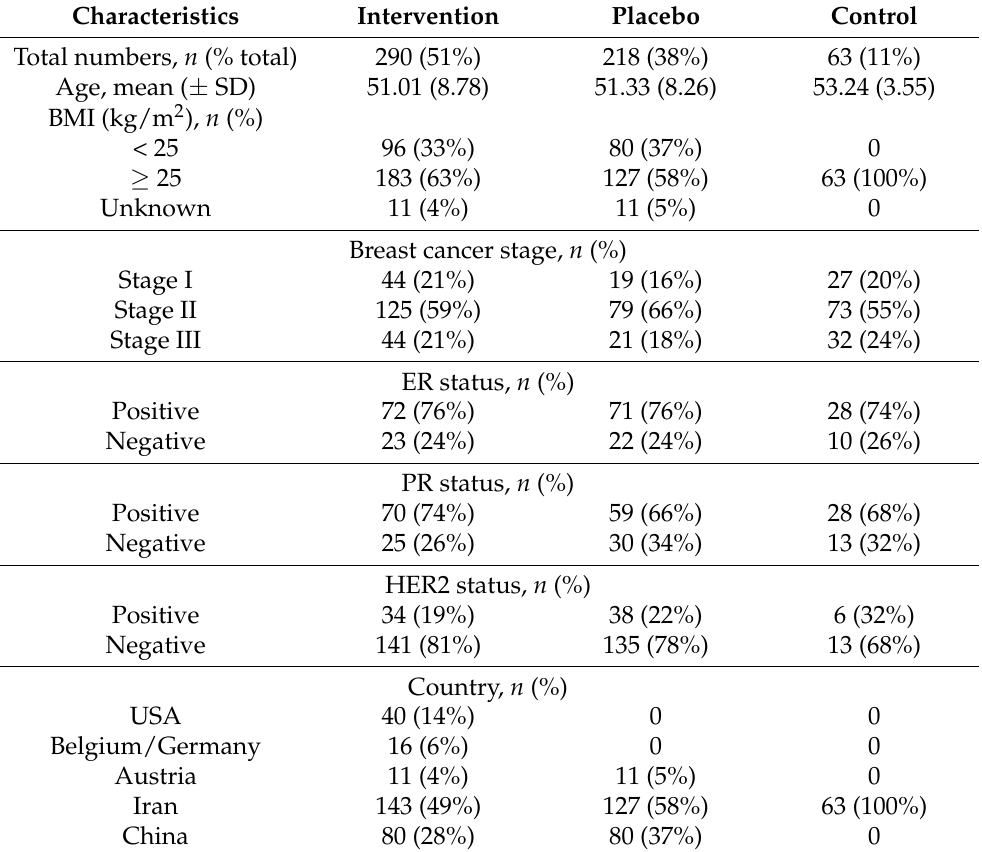
Table 2. Demographic characteristics of